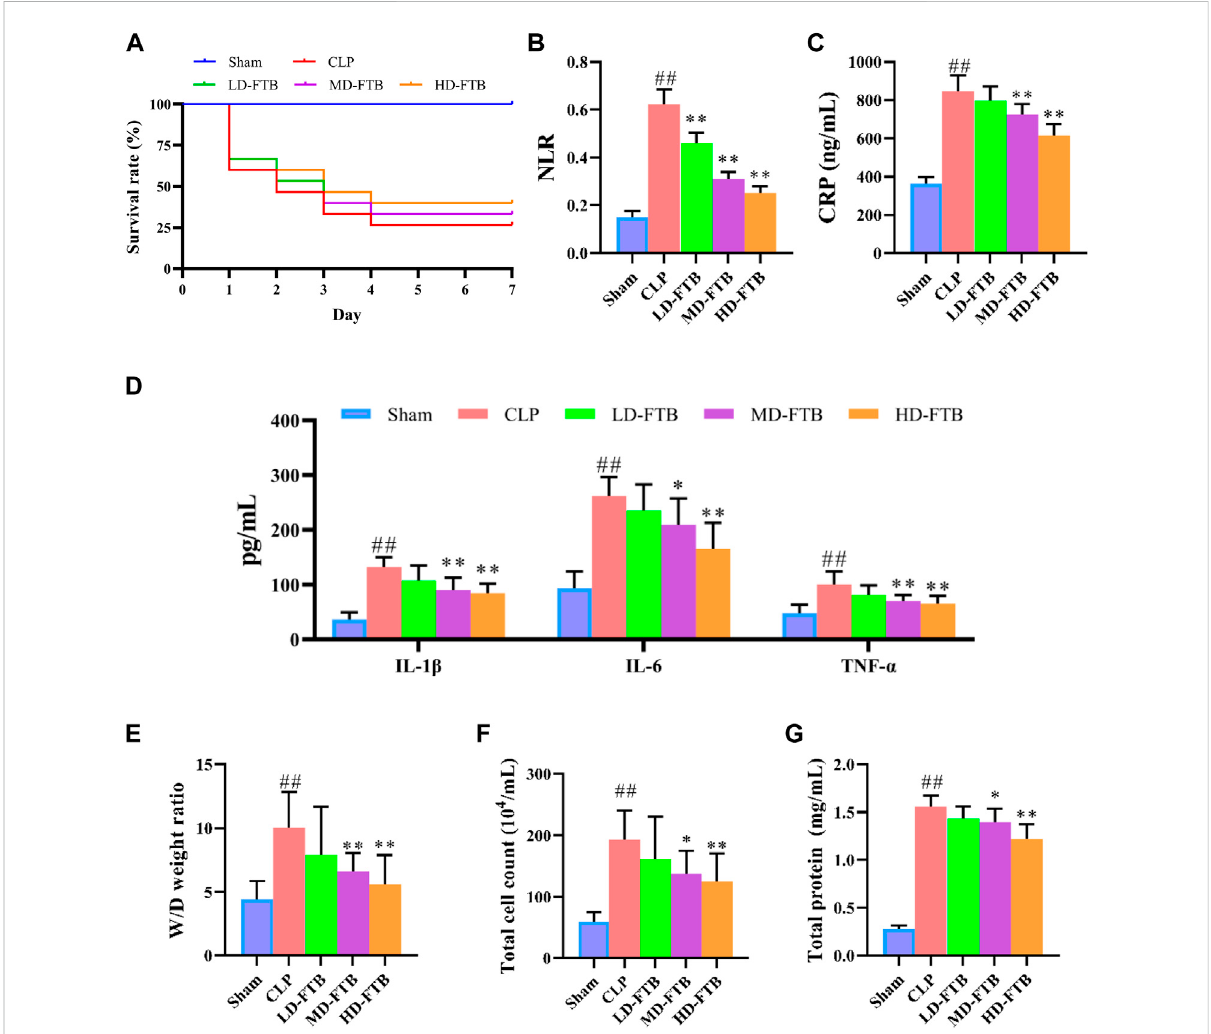
FIGURE 2 Effects of treatment with FTB on survival rate, in fl ammatory response and lung permeability in rats with sepsis. (A) FTB treatment increased the survivalrateinratswithsepsis (B – D) TheeffectsofFTBonin fl ammatoryresponsewereobservedbytestingtheneutrophil/lymphocyteratio(NLR)in peripheralblood (B) throughbloodroutineexaminationandmeasuringtheserumlevelsofCRP (C) ,IL-1 β (D) ,IL-6 (D) ,andTNF- α (D) usingELISA.FTB treatment lowered NLR and the levels of CRP, IL-1 β , IL-6, and TNF- α in rats with sepsis (E – G) The changes in lung permeability were assessed through measuring the wet-to-dry (W/D) ratio of lung tissue (E) , total cell count (F) and in total protein concentration (G) in bronchoalveolar lavage fl uid (BALF). FTB treatment decreased the W/D ratio of lung tissues, total protein concentration and total cell count in BALF. (A) : n = 15 per group at day 0; (B – G) : sham group ( n = 15), CLP group ( n = 8), LD-FTB ( n = 9), MD-FTB ( n = 10), HD-FTB ( n = 12)